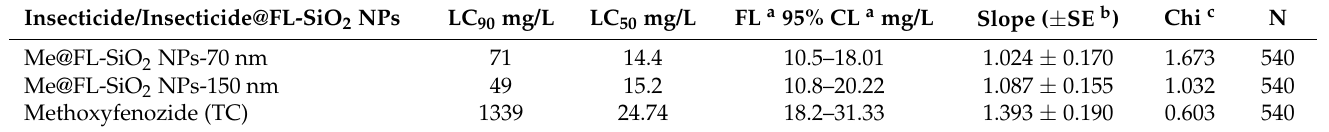
Table 2. Dose–response toxicity assay of methoxyfenozide (TC), Me@FL-SiO 2 NPs-70 nm, and